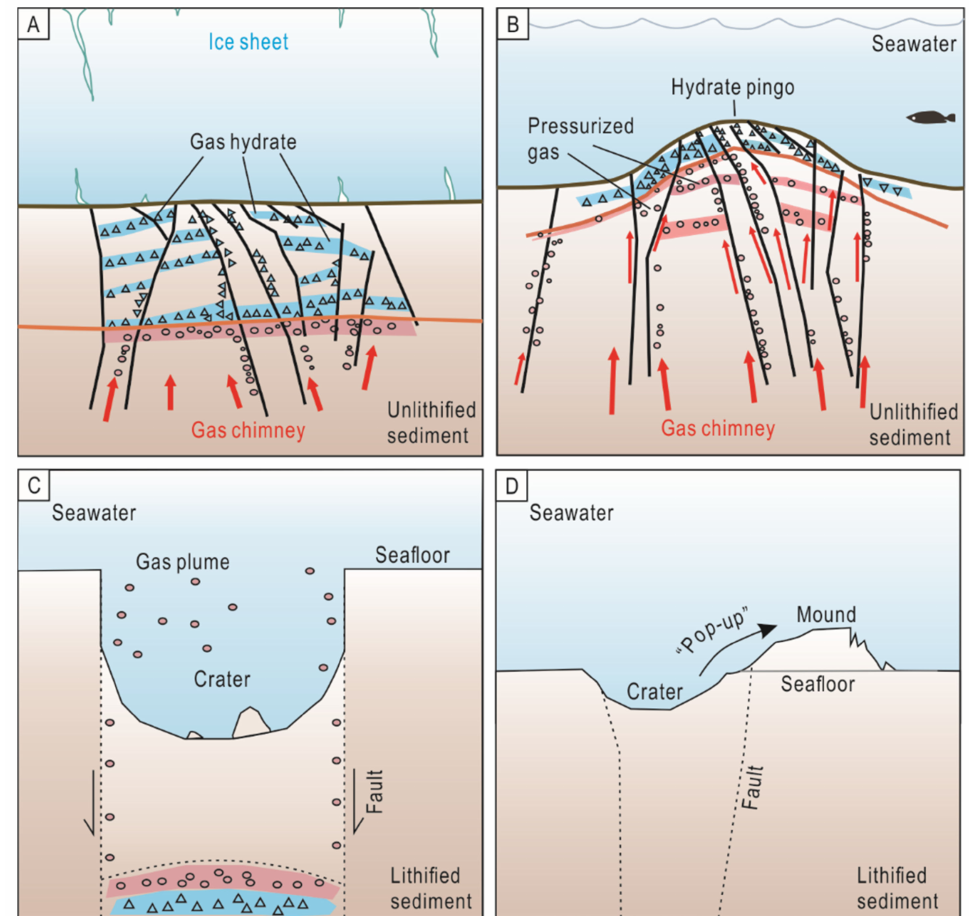
Figure 8. ( A , B ): Formation of gas hydrate pingoes at the top of chimneys at Storfjordrenna, northwest- ern Barents Sea (modified from [41,42]). ( A ) GHSZ beneath the seabed–ice interface; ( B ) GHSZ shoals caused by pressure and temperature changes during deglaciation. ( C , D ): Craters and mounds at Bjørnøyrenna, north Barents Sea, and at Storbanken, central Barents Sea (drawn according to [39]). ( C ) Formation of craters defined by faults caused by the dissociation of underlying hy- drates. ( D ) Crater–mound pair. Hydrate growth in unlithified sediments produces “pop-up” mud mounds rather than hydrate pingoes growing in